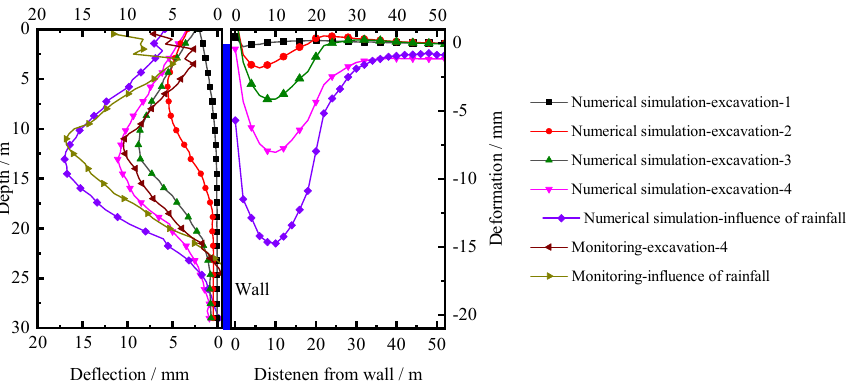
Figure 5. The contrast between the numerical simulation and monitoring of the lateral displacement of the wall and ground settlement.